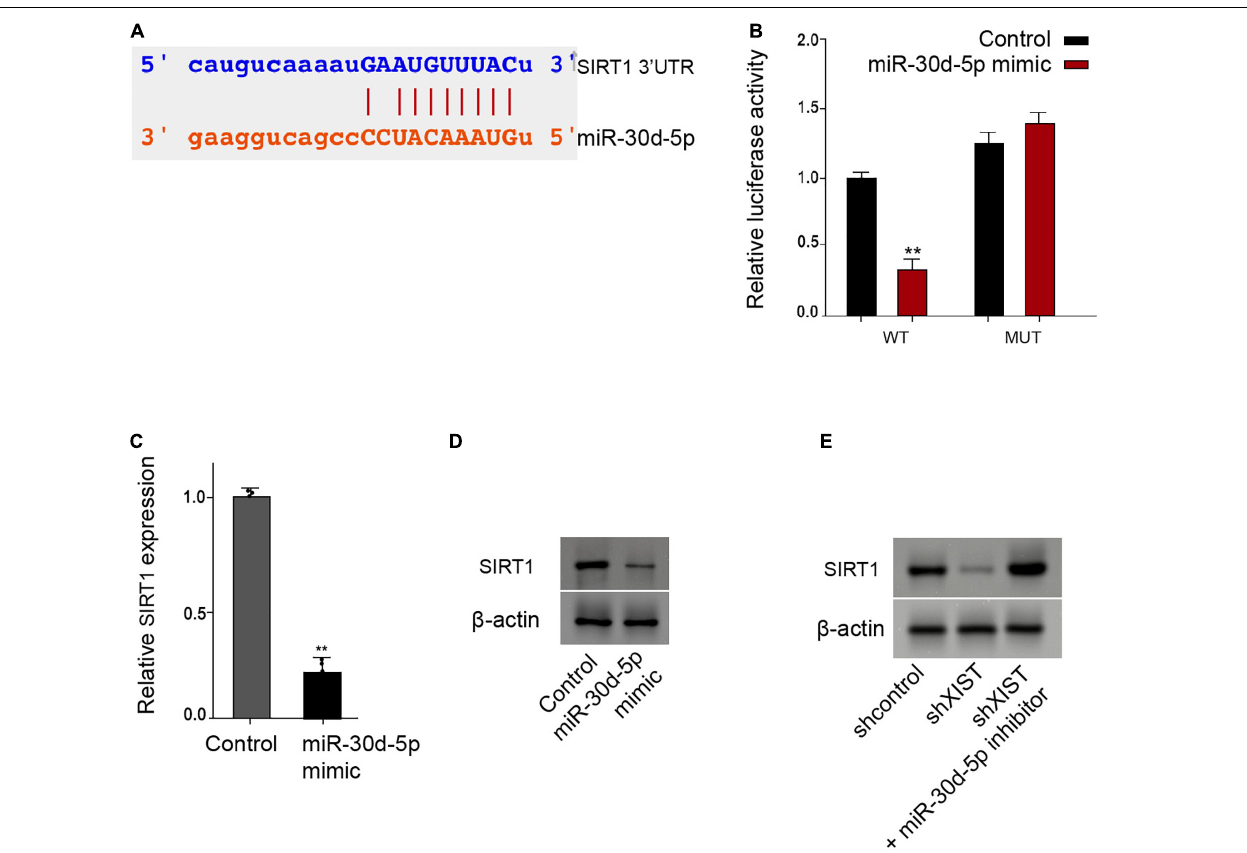
FIGURE 6 | MiR-30d-5p is able to target SIRT1 in the Schwann cells. (A) Bioinformatic analysis using Targetscan (http://www.targetscan.org/vert_72/) shows the interaction of SIRT1 with miR-30d-5p. (B–D) The RSC96 cells are treated with control mimic or miR-30d-5p mimic. (B) The luciferase activities of wild-type SIRT1 (WT) or mutant SIRT1 (MUT) are detected by luciferase reporter gene assays. (C) The expression of SIRT1 is examined by qPCR assays. (D) The expression of SIRT1 is examined by Western blot analysis. (E) The RSC96 cells are treated with control shRNA or XIST shRNA, or co-treated with XIST shRNA and miR-30d-5p inhibitor. The expression of SIRT1 is examined by Western blot analysis. N = 3, mean ± SD, * P < 0.05, ** P <